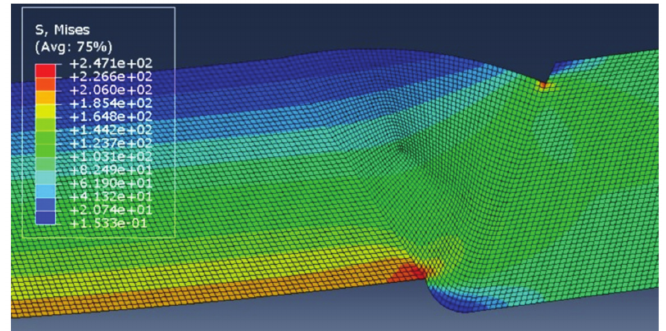
Figure 6. Results for the model with excess weld metal, incomplete root penetration, and undercut.